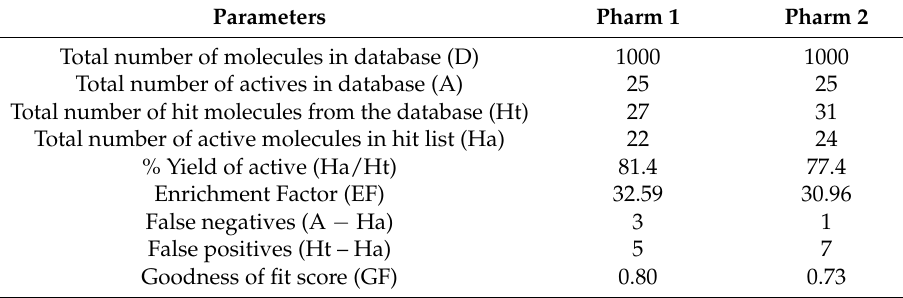
Table 3. Different values computed by pharm 1 and pharm 2 employing decoy set